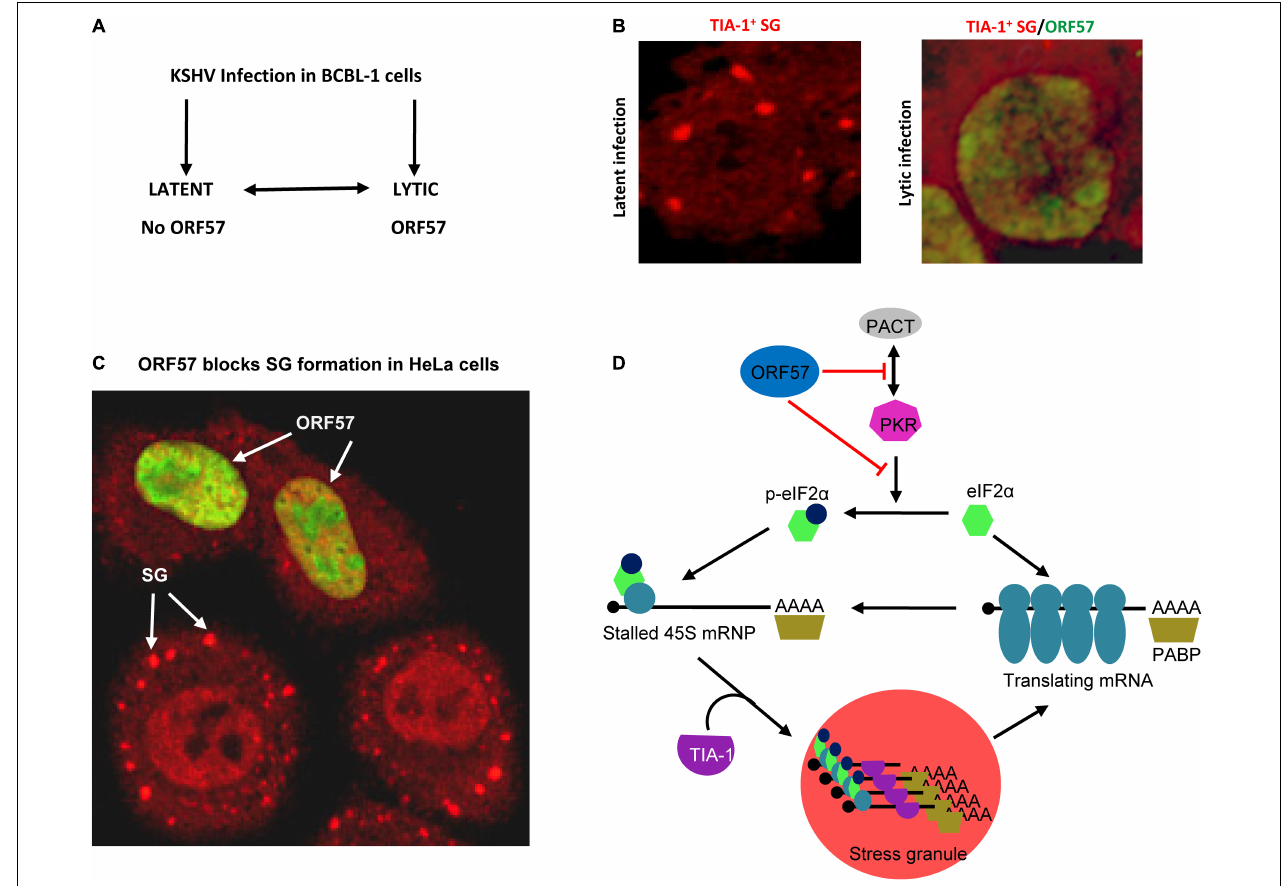
FIGURE 4 | Disruption of SG assembly during KSHV lytic infection. (A) Flow diagram showing the exchangeable progression of lytic and latent phases of KSHV infection in BCBL-1 (B lymphocytes) cells. (B) Left panel, a BCBL-1 cell carrying latent KSHV infection showing SG (red) by immunostaining with an anti-TIA-1 antibody after treatment with 0.5 mM arsenite for 30 mins. Right panel, inhibition of SG assembly during KSHV lytic infection by expression of viral ORF57 (green). (C) Ectopic ORF57 inhibiting SG formation in HeLa cells under ARS stress. (D) Schematic model depicting the ORF57 interactions with PACT and PKR to block PKR dimerization and activation and thus inhibit SG formation during KSHV lytic infection. Panel (D) is modified from our previously published figure (Sharma et al.,